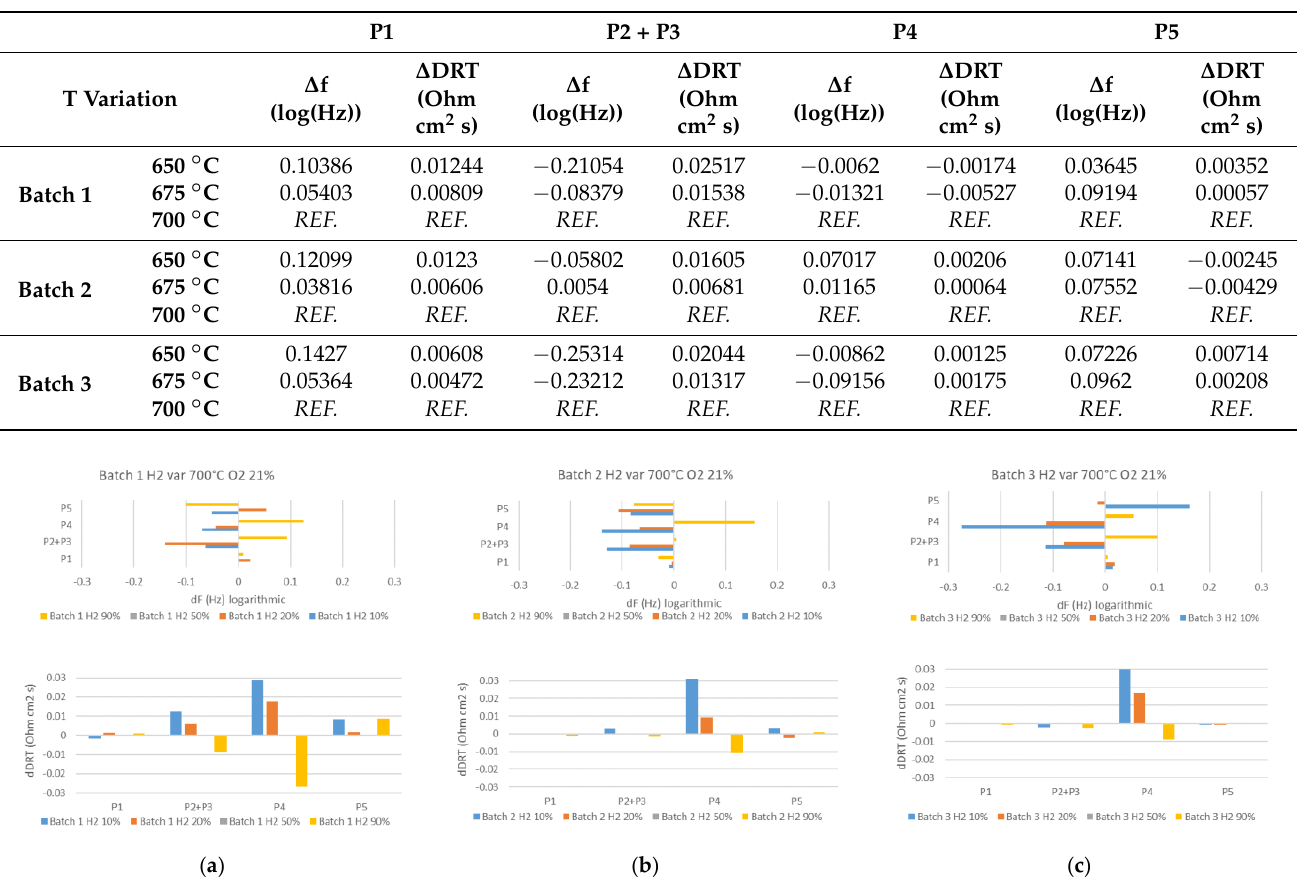
Figure 10. Frequency and DRT change due to hydrogen variation at 700 °C and O 2 21%. ( a ) Batch 1. ( b ) Batch 2. ( c ) Batch 3.